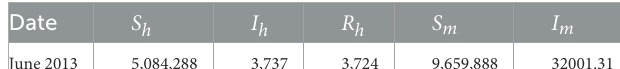
TABLE 3 Initial values of all variables of